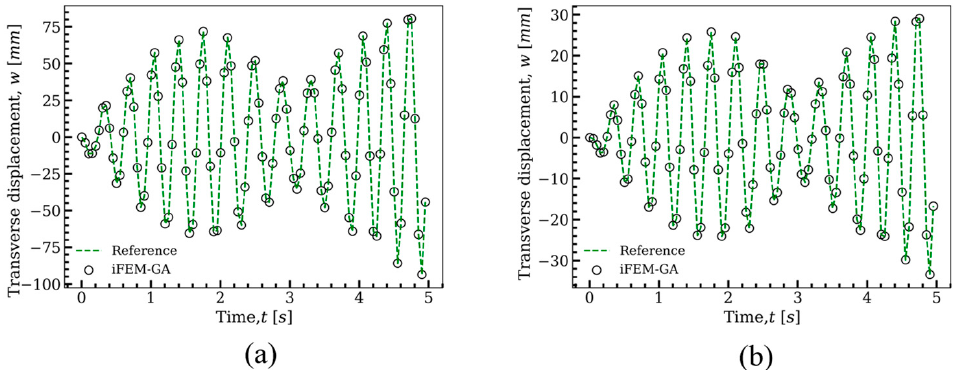
Figure 10. Time history of the transverse displacement of the plate depicted in Figure 4 under the load of F = 5sin ( ω p t ) with ω p = 18.83 rad/s. A comparison reference solution and iFEM-GA analysis at position ( a ) P 1 ( x = 500 mm, y = 1000 mm ) , ( b ) P 2 ( x = 500 mm, y = 500 mm )